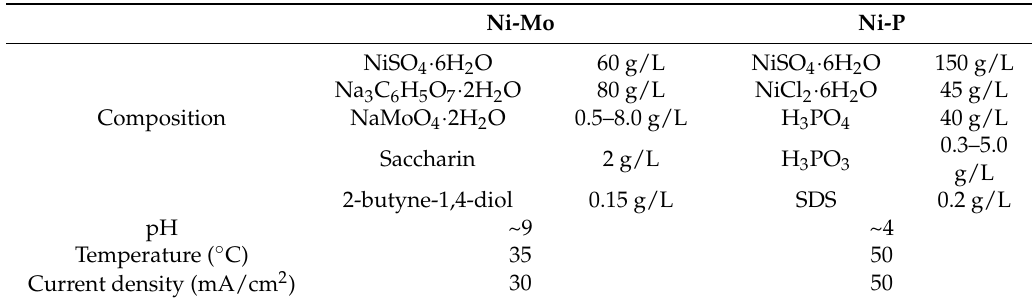
Table 1. Electrolyte composition and operating condition for the electrodeposition of ng Ni-Mo and